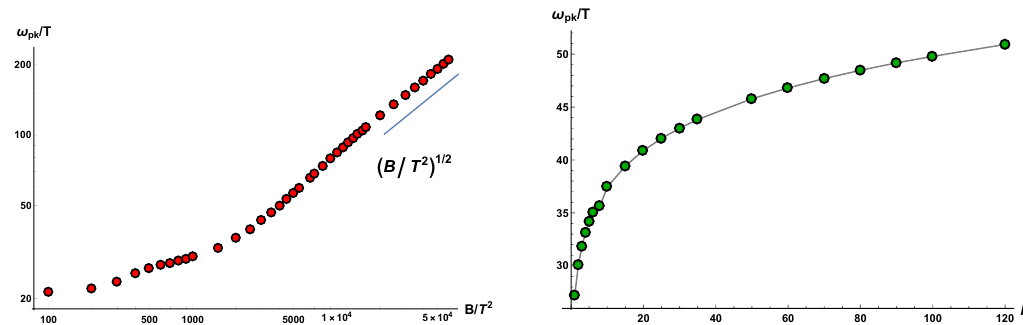
Figure 20 . Left: Behavior of the peak in the longitudinal conductivity Re [ (cid:27) xx ] at large B=T 2 . The asymptotic behavior is consistent with a scaling ! pk (cid:24) B 1 = 2 . Right: Dependence of the peak position ! pk as a function of the parameter (cid:12) , which determines the strength of the SSB | the shear elastic modulus. The peak is extracted both from the real part of the longitudinal